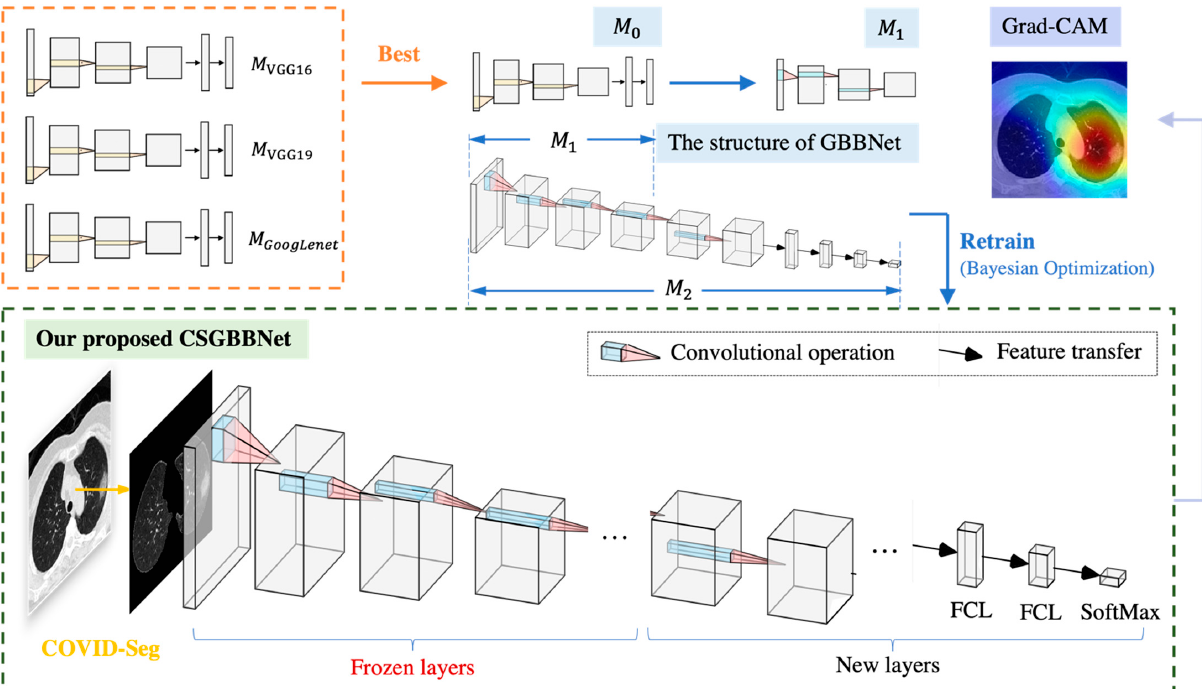
Figure 10. A simplified method diagram for our proposed CSGBBNet. The feature representation of each image is extracted by several convolutional operations and then be mapped into the FCL to reduce the dimension, and finally the prediction probabilities for classes are output. ( M 0 : The optimal selection of pre-trained models. M 1 : The model achieved by removing the last L learnable layers from M 0 . M 2 : The model achieved by adding five new designed layers/blocks into M 1